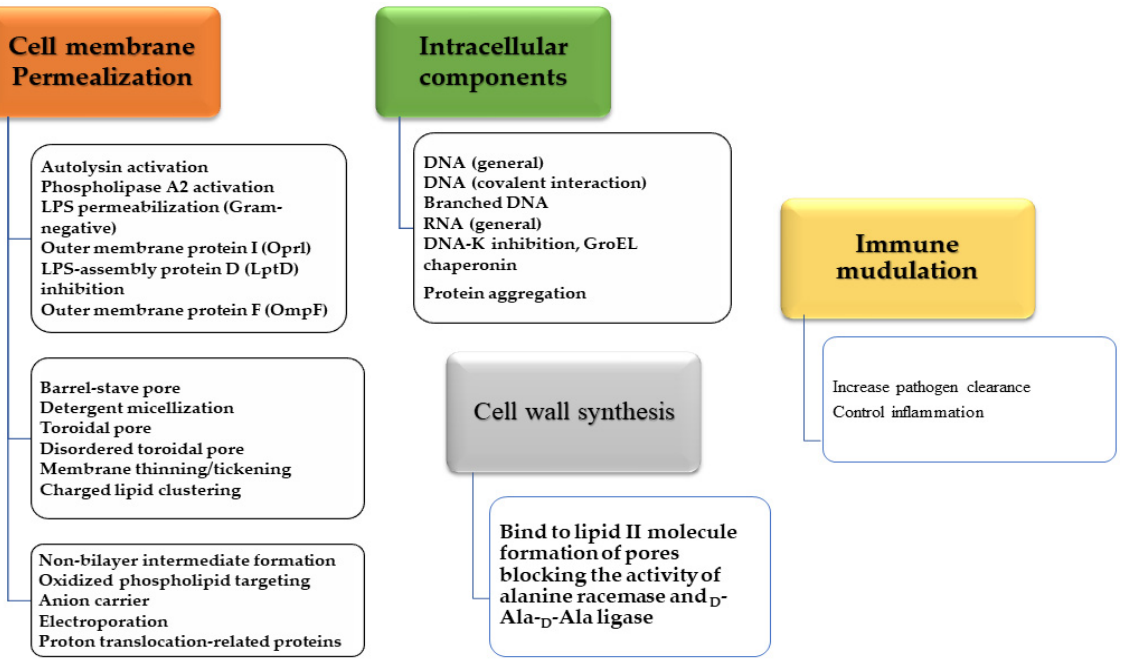
Figure 4. The mechanisms of antibacterial action of AMPs.